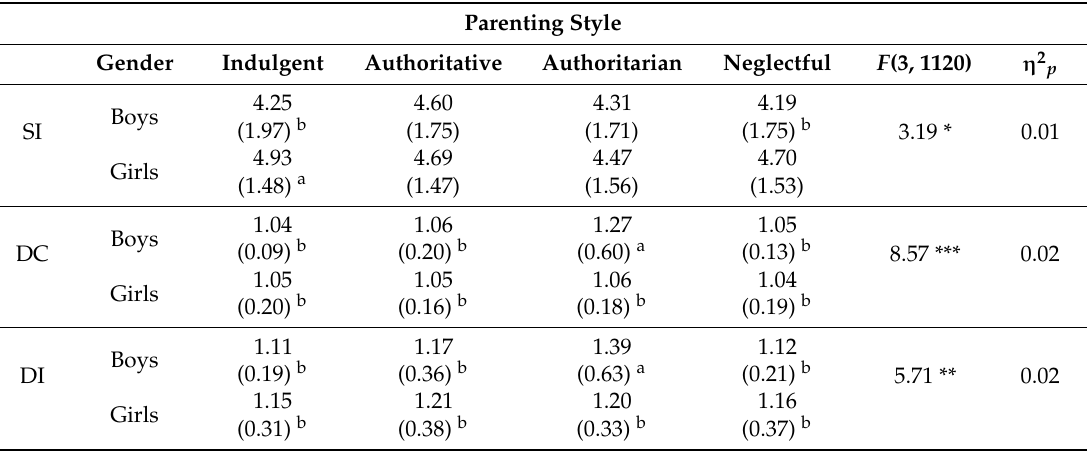
Table 5. Means (Standard deviations), F values, and Bonferroni post hoc test for the parenting style groups across